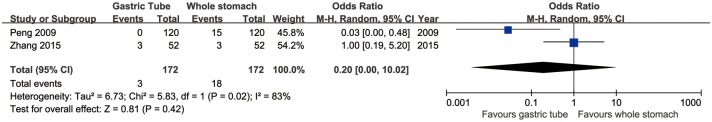
Forest plot of delayed gastric emptying in the whole-stomach and gastric-tube groups.